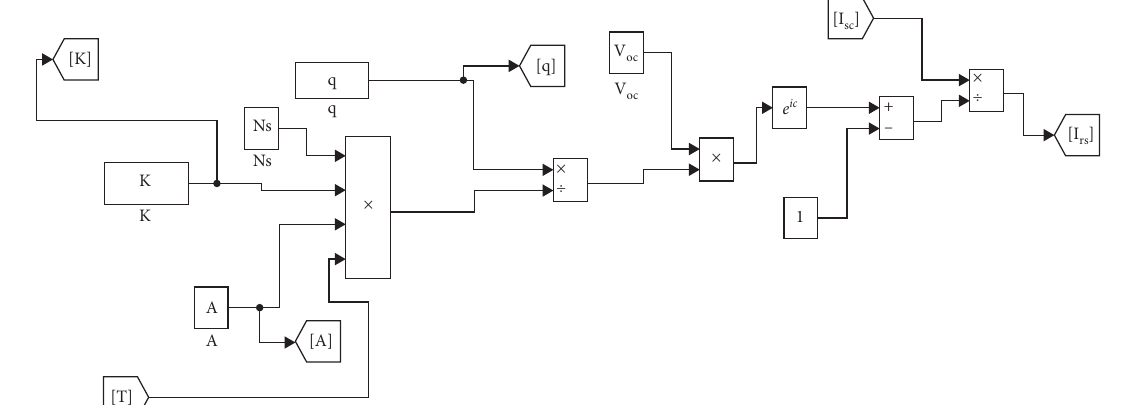
Figure 19: Modelled and Implemented I